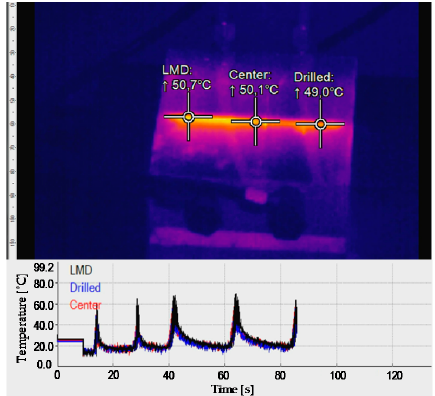
Figure 7. Cooling capacity when laser and water-cooling are both active.